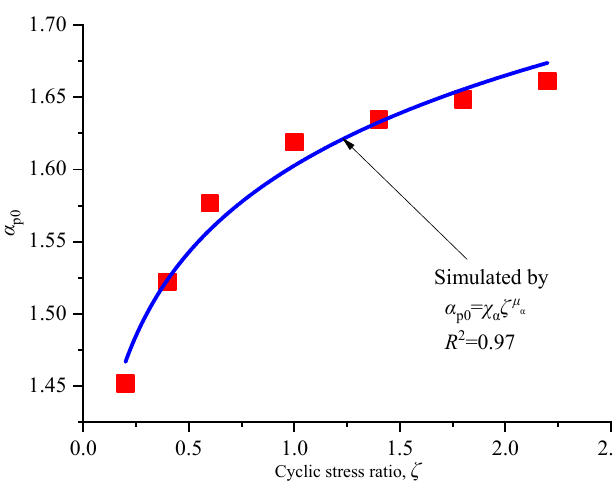
Figure 7. Relationship between parameter α p0 and cyclic stress ratio ζ .